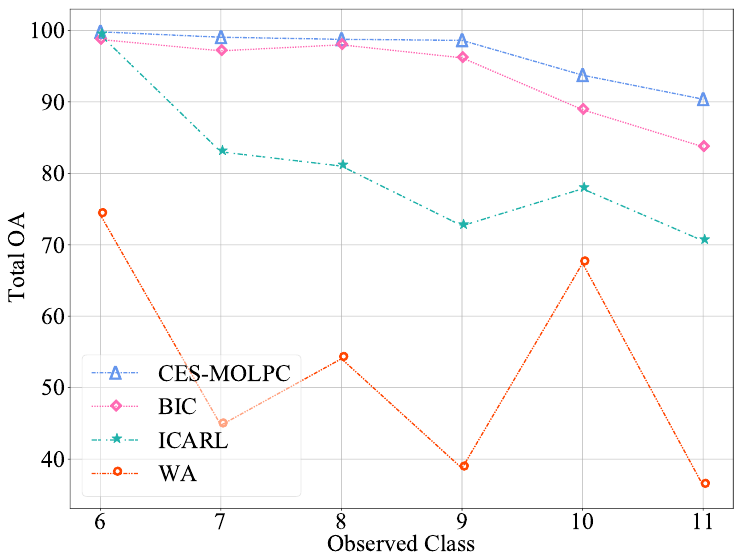
Figure 3. The Total OA of multiple incremental classification on the RML2016.04c data set ( T = 1).